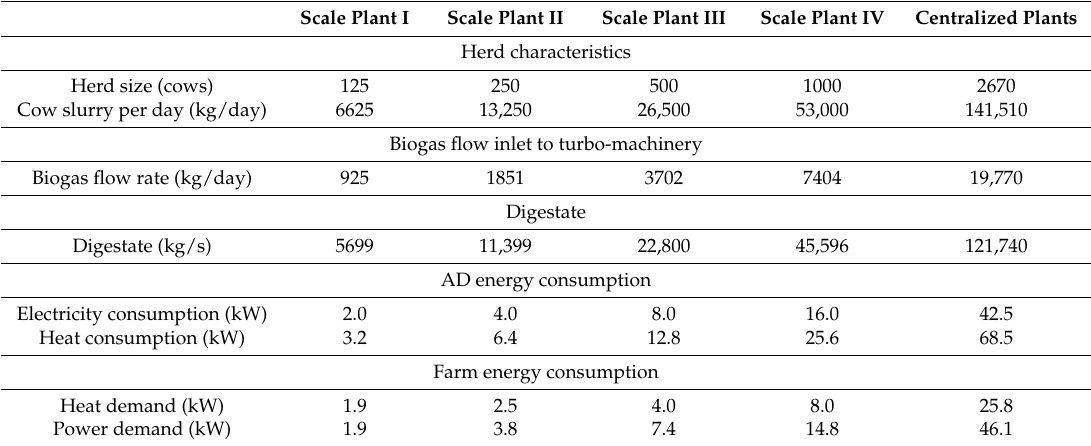
Table 3. Energy consumption and biogas yield for the different plant scale under